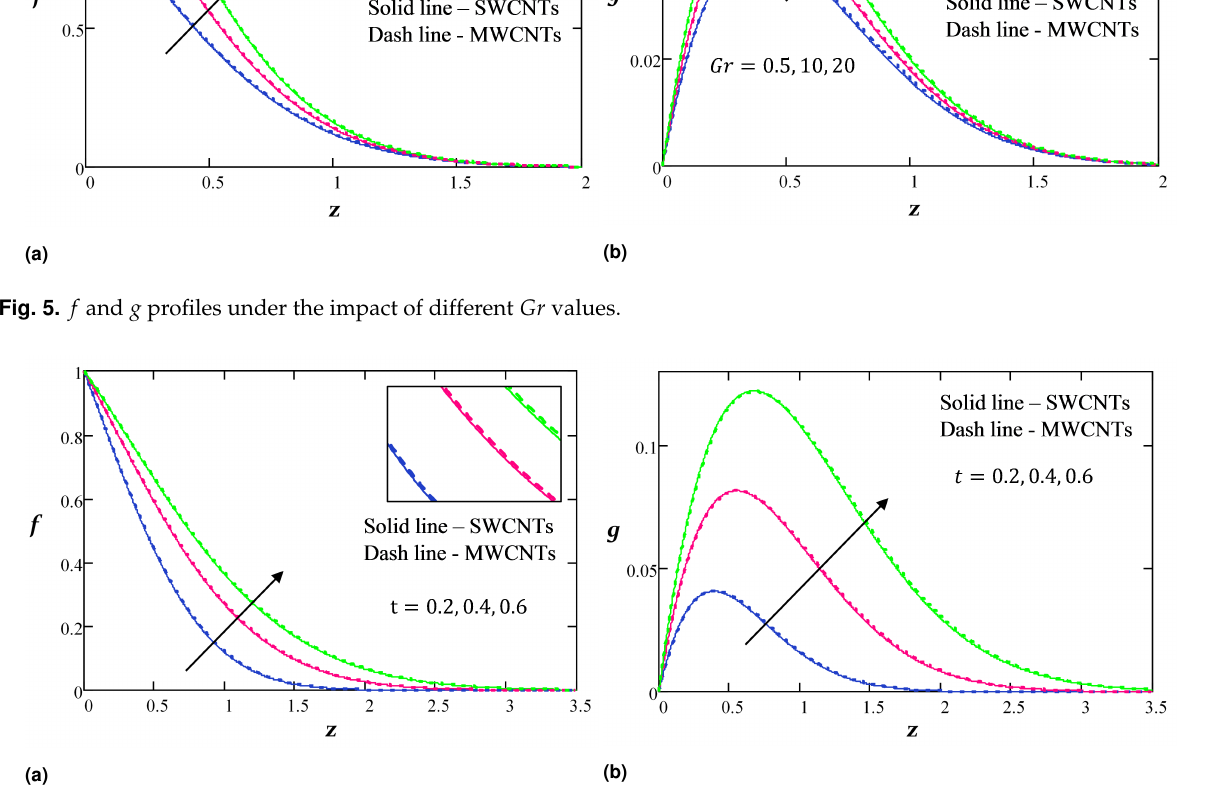
Fig. 6. f and g profiles under the impact of different t values.